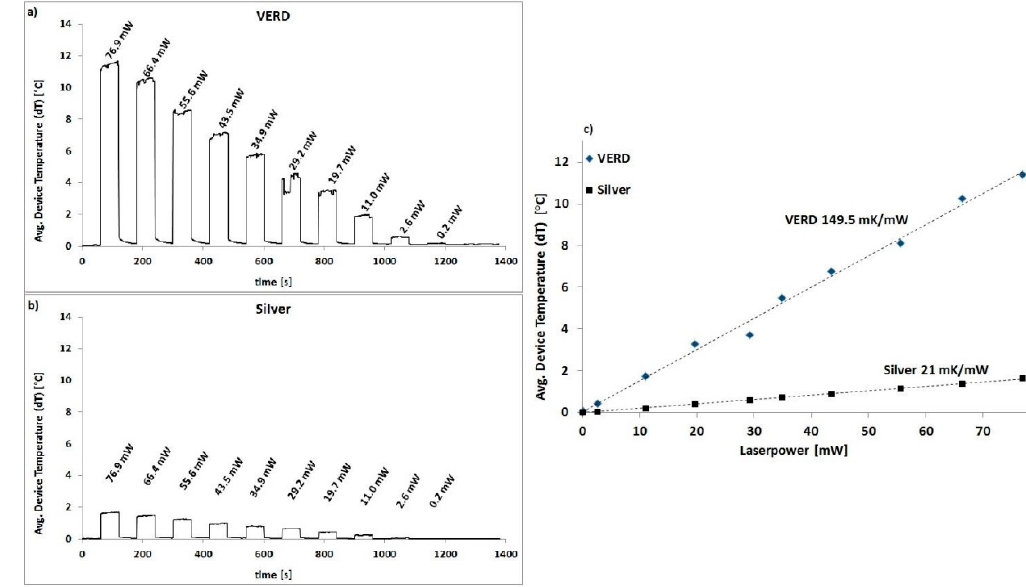
Figure 3. Heating characteristics of the VERD ( a ) and bare silver surface ( b ) of the best performing meander structure C6-5. ( c ) Extracted responsivity expressed as average device temperature increase in dependence of laser